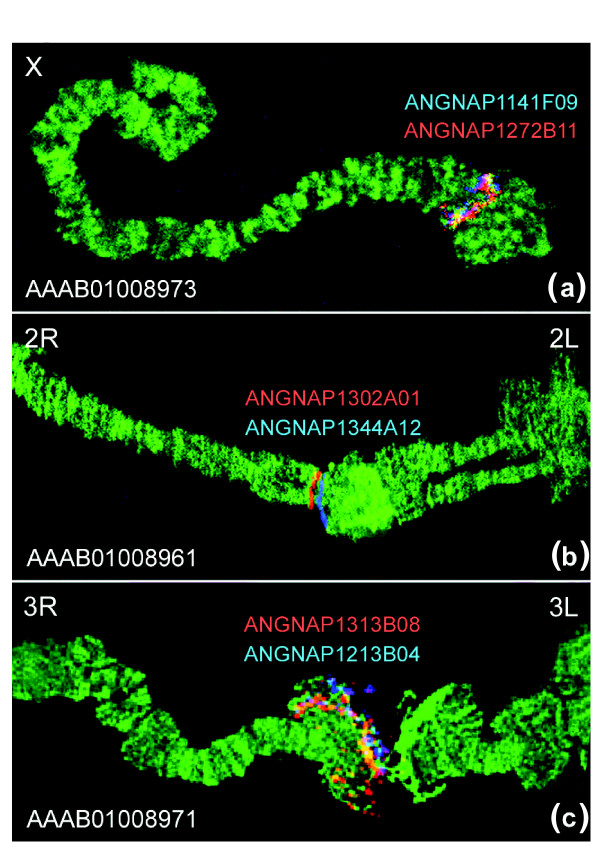
Results of in situ hybridization of cDNA clones to the heterochromatic regions on the polytene chromosomes of A. gambiae. Two cDNA clones were labeled with red Cy3 and blue Cy5 dyes and hybridized to the polytene chromosomes: the red signals indicate the beginning and the blue signals show the end of the scaffolds. The location of the scaffolds, (a) AAAB01008973, (b) AAAB01008961 and (c) AAAB01008971, were indicated by in situ hybridization of the cDNA clones: ANP1272B11, ANP1141F09 (a); ANP1302A01, ANP1344A01 (b) and ANP131B08, ANP121D04 (c) on the chromosome X (a), 2 (b) and 3 (c).